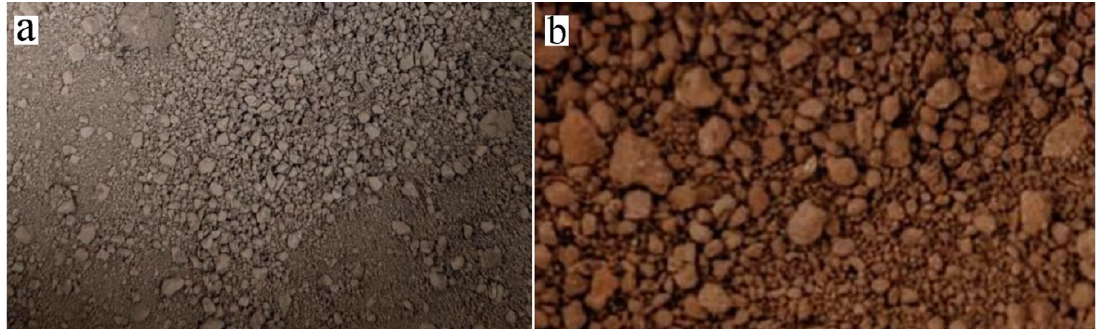
Figure 2. Particle size distribution of concentrated sulfide gold sample.